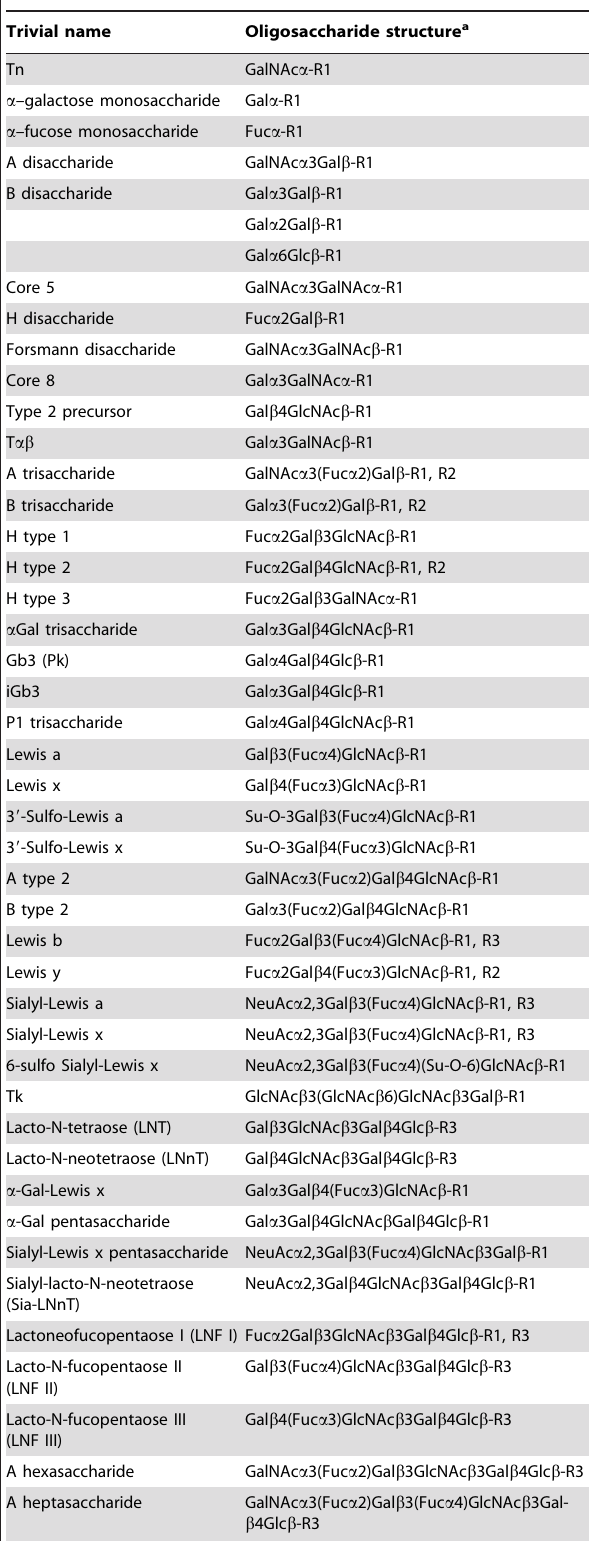
Table 1. Neoglycoconjugates used to determine the carbohydrate specificity of rNB2